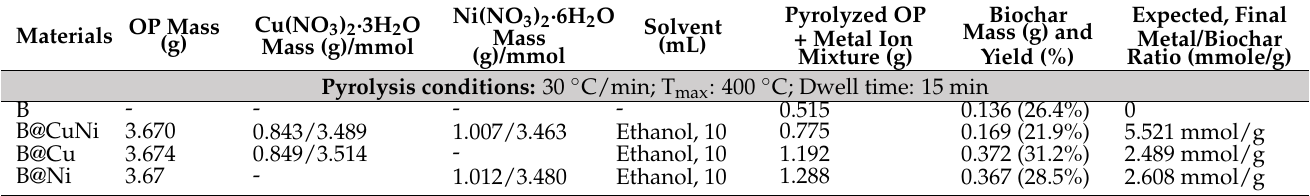
Table 1. Biochar loads and weights with copper and nickel: from the olive pit (OP) to the CuNi-decorated biochar, including pyrolysis